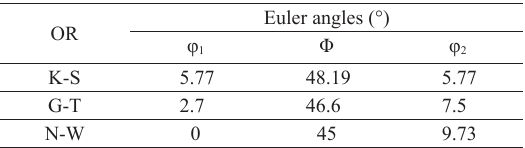
Table 1. ORs between face centered cubic and body centered cubic